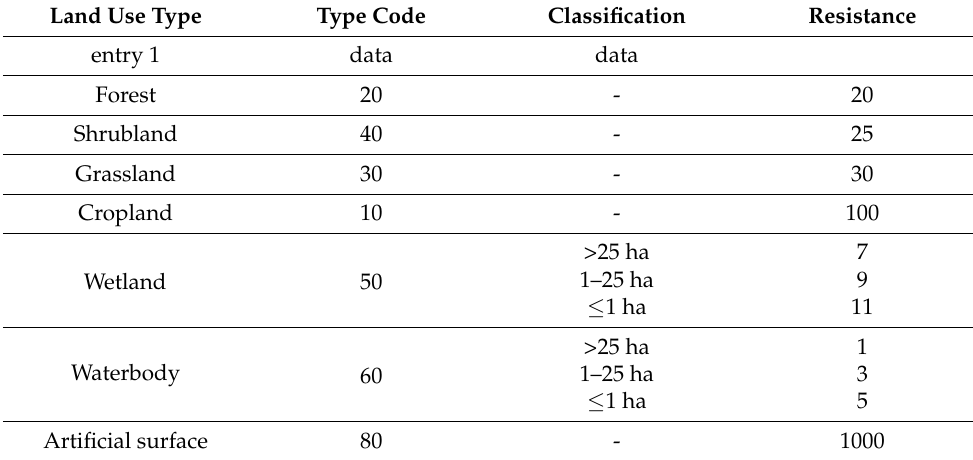
Table 1. Resistance value of different land use